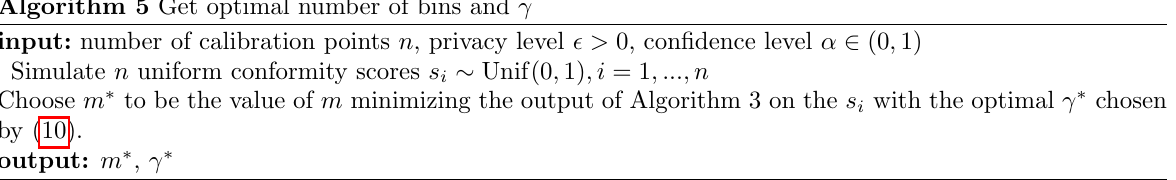
Algorithm 5 Get optimal number of bins and